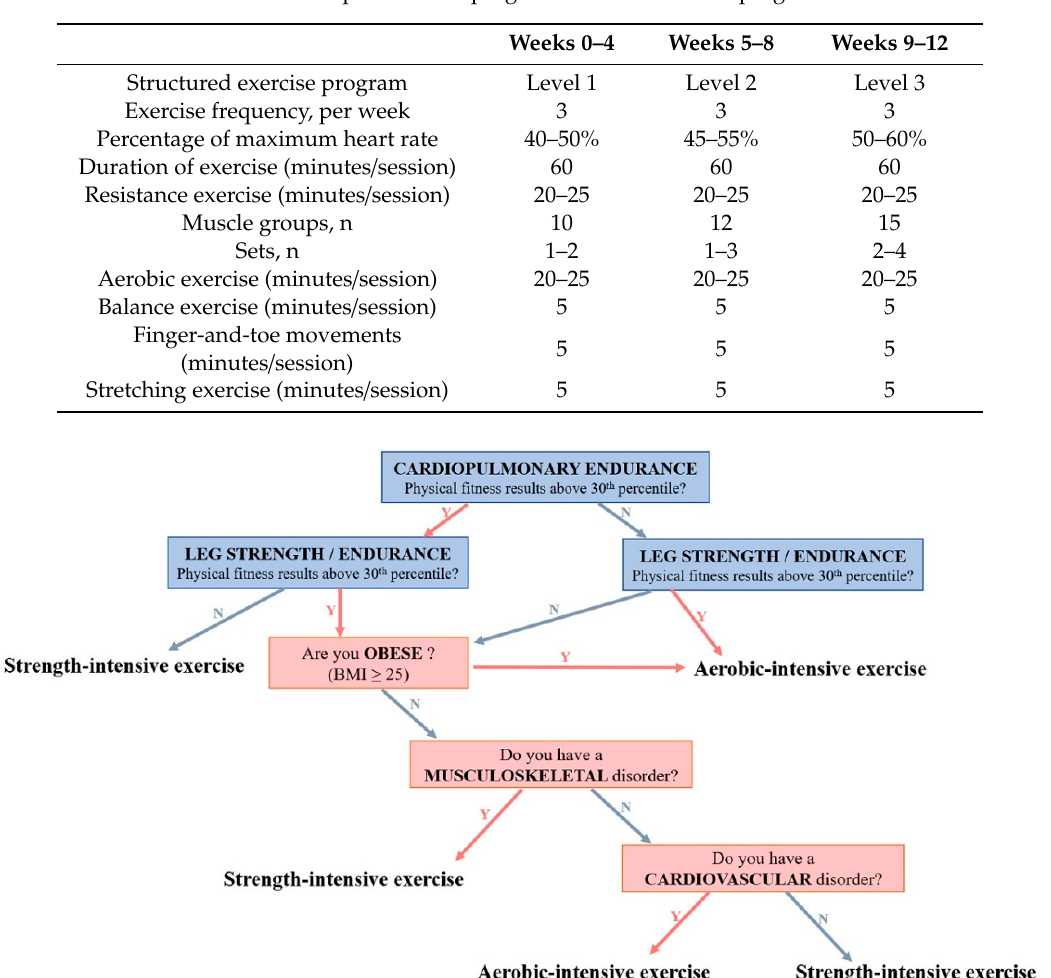
Figure 1. Algorithm for recommendation of exercise types based on physical performance and medical conditions. Cardiopulmonary endurance and leg strength / endurance were determined by the records of 2 min walk steps and sit-to-stand for 30 s, respectively. Poor physical fitness was defined as the recorded physical performance in any test being below the 30th percentile of the norms for the normal population matched for age and sex.